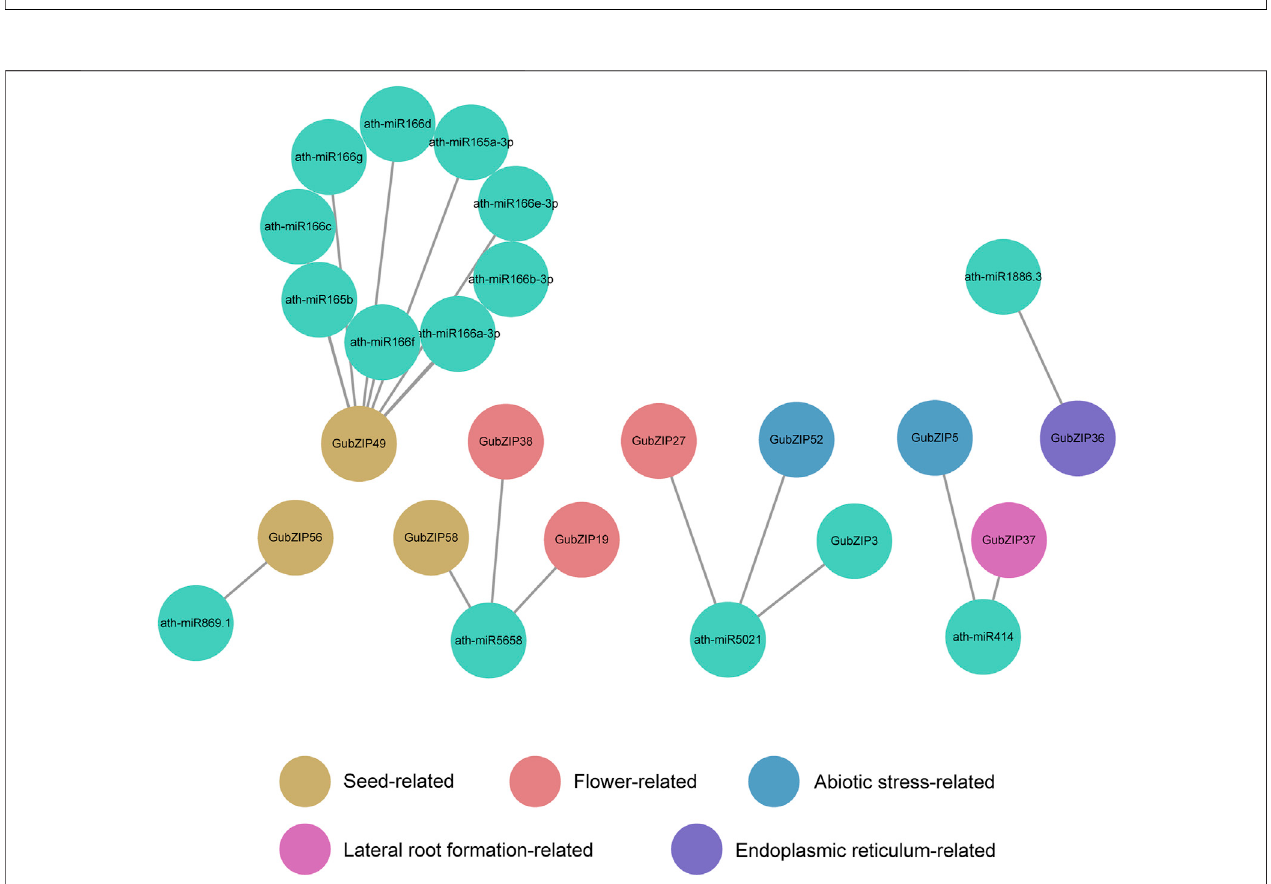
FIGURE 6 | Interaction network of miRNAs and their targeted GubZIPs using Cytoscape software.